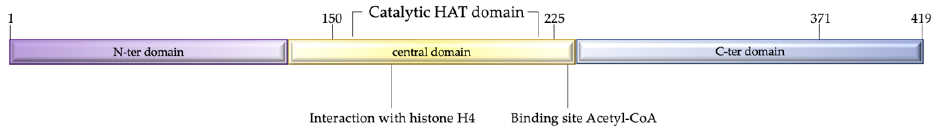
Figure 2. Schematic diagram of the structure of HAT1 protein.